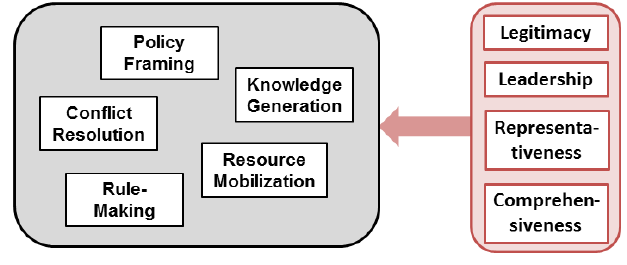
Fig. 1 . Functional model of a policy trajectory comprising a set of interdependent elements (left box) and properties characterizing the performance of these elements (right box). Note: the figure presents elements assumed to be necessary for dealing with a complex policy problem, without assuming a sequential logic among them. Interdependencies between elements may be complex and